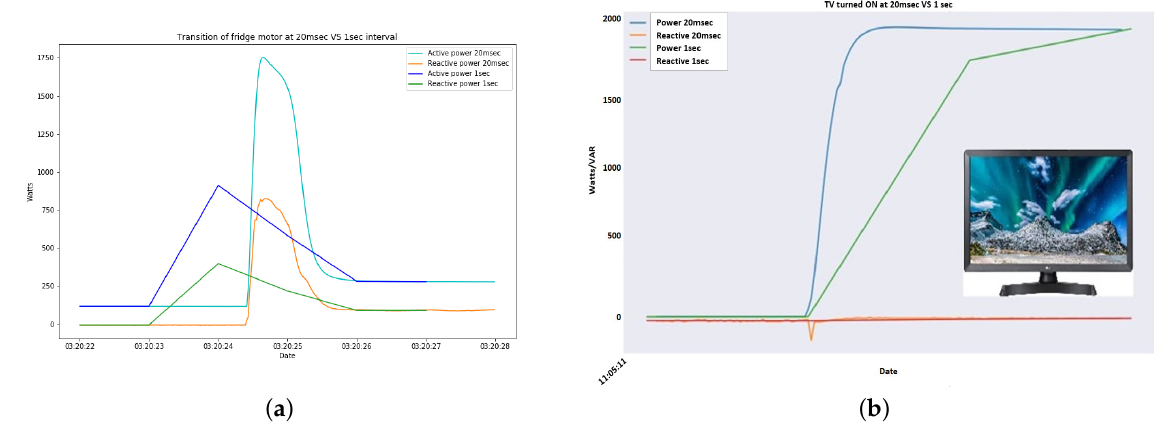
Figure 1. Comparing time intervals. ( a ) Measuring fridge’s consumption; ( b ) Measuring TV’s consumption.